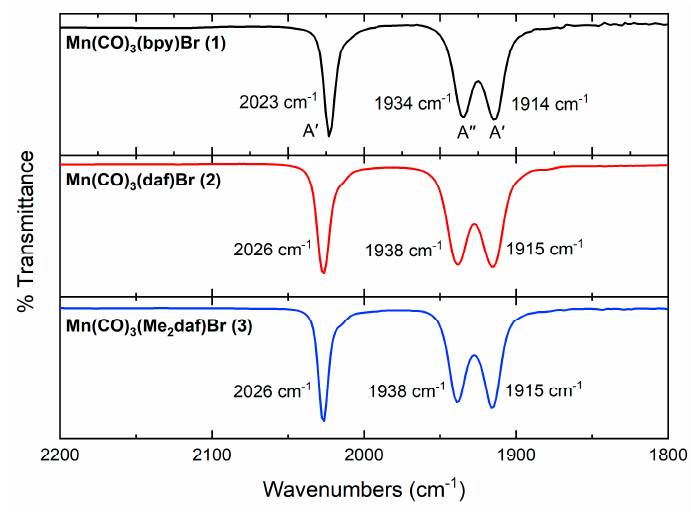
Figure 3. FTIR spectra of 1 – 3 in THF solution.